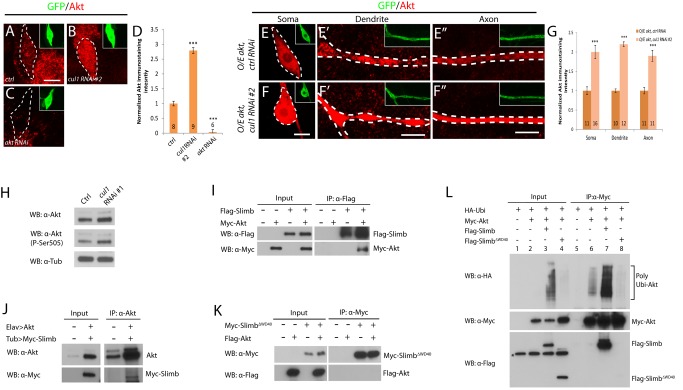
Slimb forms a protein complex with Akt and promotes Akt ubiquitination.(A–C and E–F″) Confocal images show Akt stainings (in red) in various genotypes of ddaC neurons expressing UAS-mCD8-GFP driven by ppk-Gal4 at WP. ddaC somas/dendrites/axons are marked by dashed lines. Endogenous Akt level was significantly upregulated in the somas of cul1 RNAi ddaC neurons (B and D) compared to that in the control RNAi somas (A and D). Akt signals were abolished in akt RNAi ddaC neurons (C and D). Overexpressed Akt is upregulated in cul1 RNAi ddaC somas, dendrites, and axons (F–F″ and G), compared to the control RNAi (E–E″ and G). Quantification of Akt immunostaining was performed as described in Materials and Methods (D and G). The graph displays the normalized Akt immunostaining intensity and S.E.M.; n is shown on the bars ***p<0.001. The scale bars are 5 µm. (H) Akt expression and activity were upregulated in the cul1 RNAi brain extracts. (I) Slimb and Akt associated each other in S2 cells cotransfected with Flag-Slimb and Myc-Akt. (J) Akt associated with Myc-Slimb in brain extracts expressing Myc-Slimb and Akt. (K) The mutant F-box protein, SlimbΔWD40, lacking its substrate-recognition WD40 domains, did not associate with Akt in S2 cells co-transfected with Myc-SlimbΔWD40 and Flag-Akt. (L) In vivo ubiquitination assay, Slimb but not SlimbΔWD40 enhanced ubiquitination of Akt in S2 cells overexpressing HA-Ubiquitin, Myc-Akt, and Flag-Slimb or Flag-SlimbΔWD40. * indicates a nonspecific band. See genotypes in Text S1.